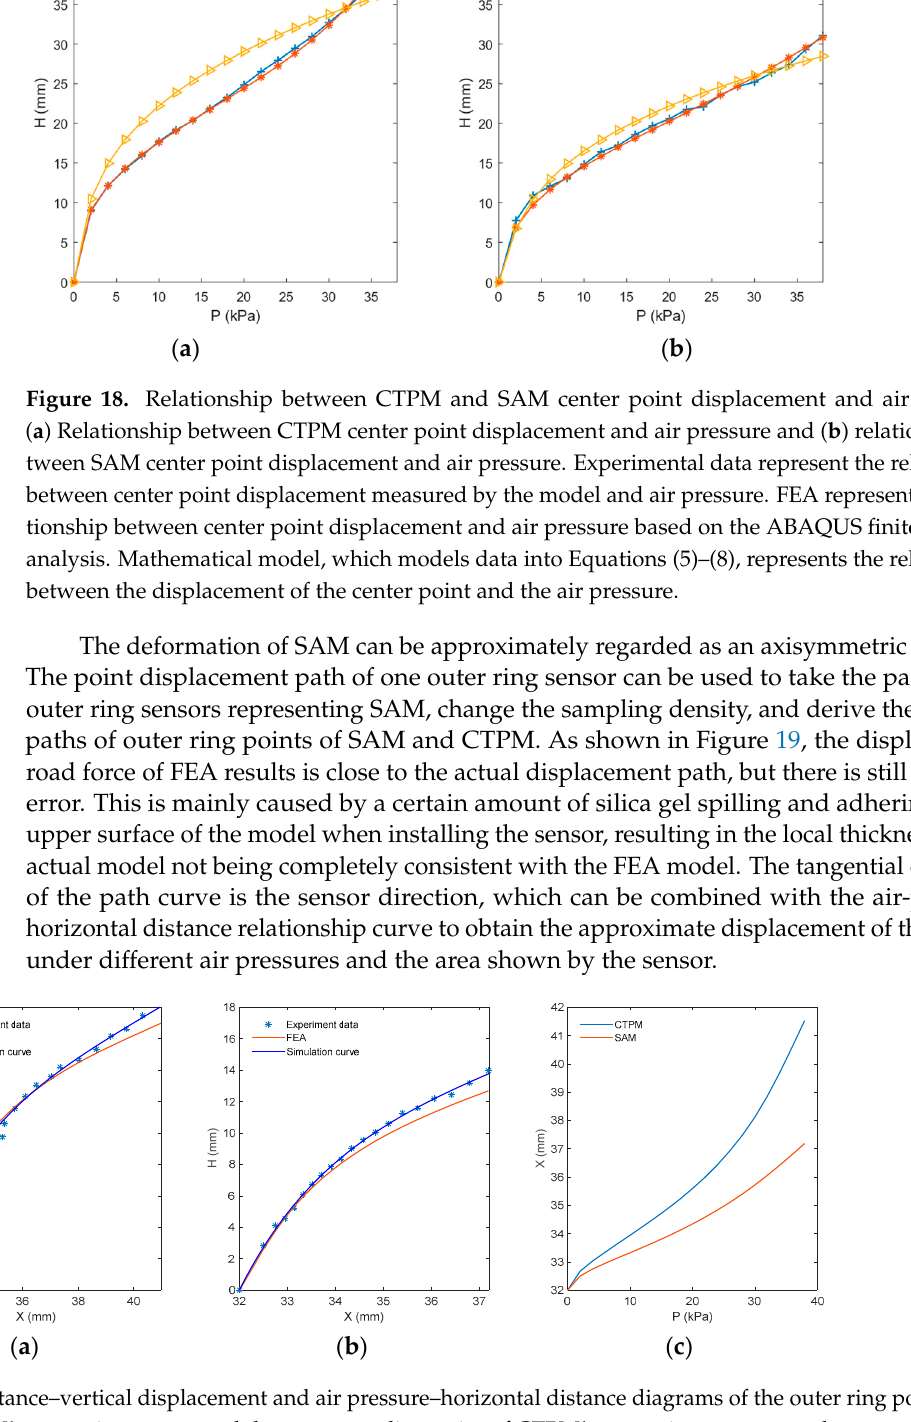
16 of 23 Figure 17. FEA and actual contour of the CTPM under different various air pressure values. The solid line represents the results of FEA based on ABAQUS, and the dotted line represents the actual measurement results. By increasing the sampling frequency of collecting air pressure for CTPM and SAM, the center point displacement of the collected results is derived. As shown in Figure 18,